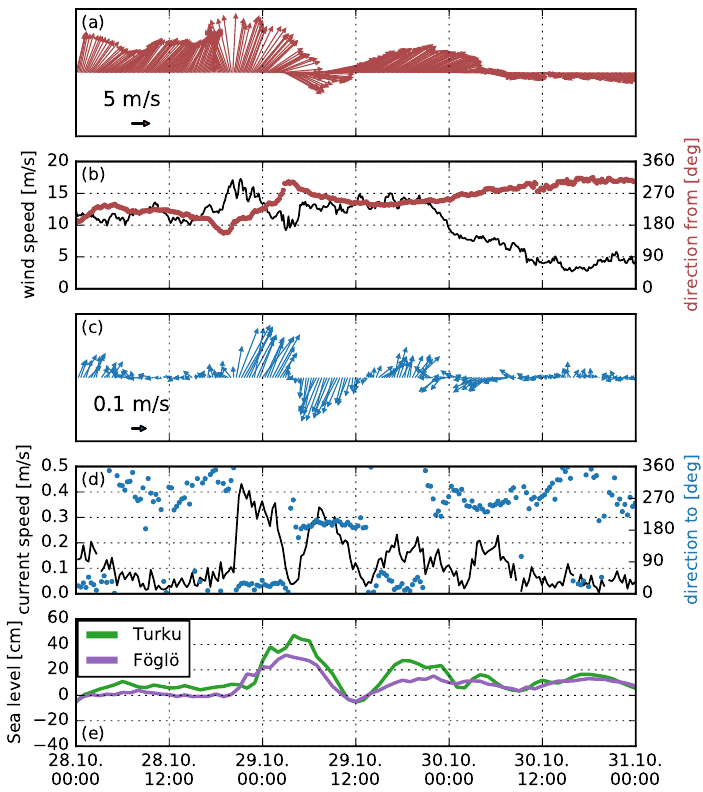
Figure 9. Wind speed and direction at Utö AWS ( a , b ), current speed and direction at Lövskär crossing ( c , d ) and sea level variation at Turku and Föglö tide gauges ( e ) 28–31 October 2013. Locations of the measurement stations shown in Figure